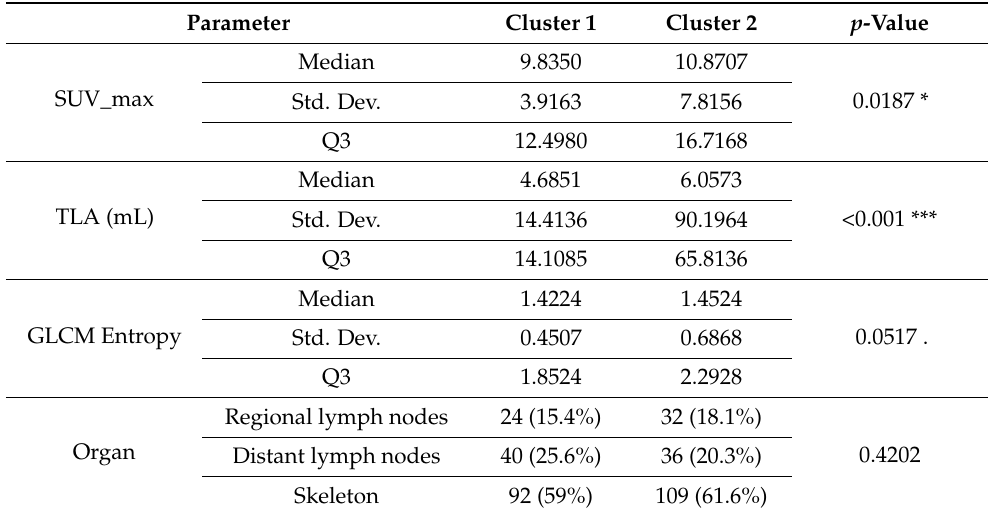
Table 2. Clusters of lesions as grouped by mini-batch k-means clustering were characterized in terms of TLA, SUV, site, and GLCM entropy and results are displayed ( p